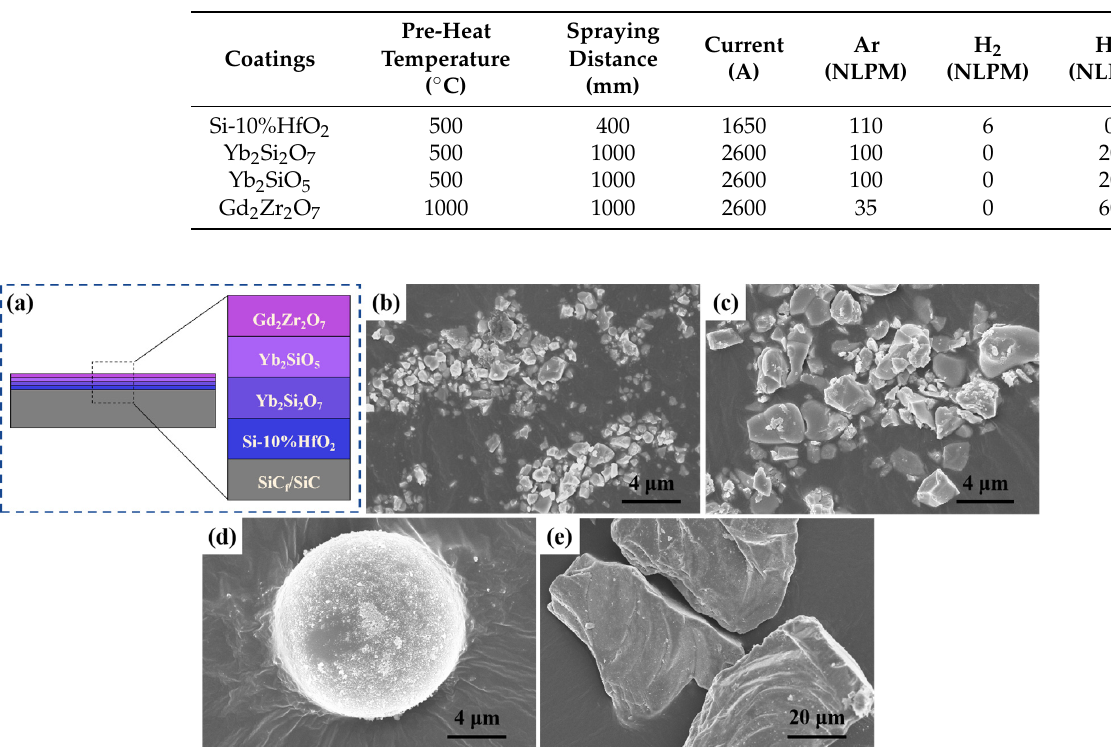
Figure 1. ( a ) Schematic diagram of T/EBCs coating structure. The SEM images of each coating powder of T/EBCs: ( b ) Si–HfO 2 ; ( c ) Yb 2 Si 2 O 7 ; ( d ) Yb 2 SiO 5 ; ( e ) Gd 2 Zr 2 O 7 .